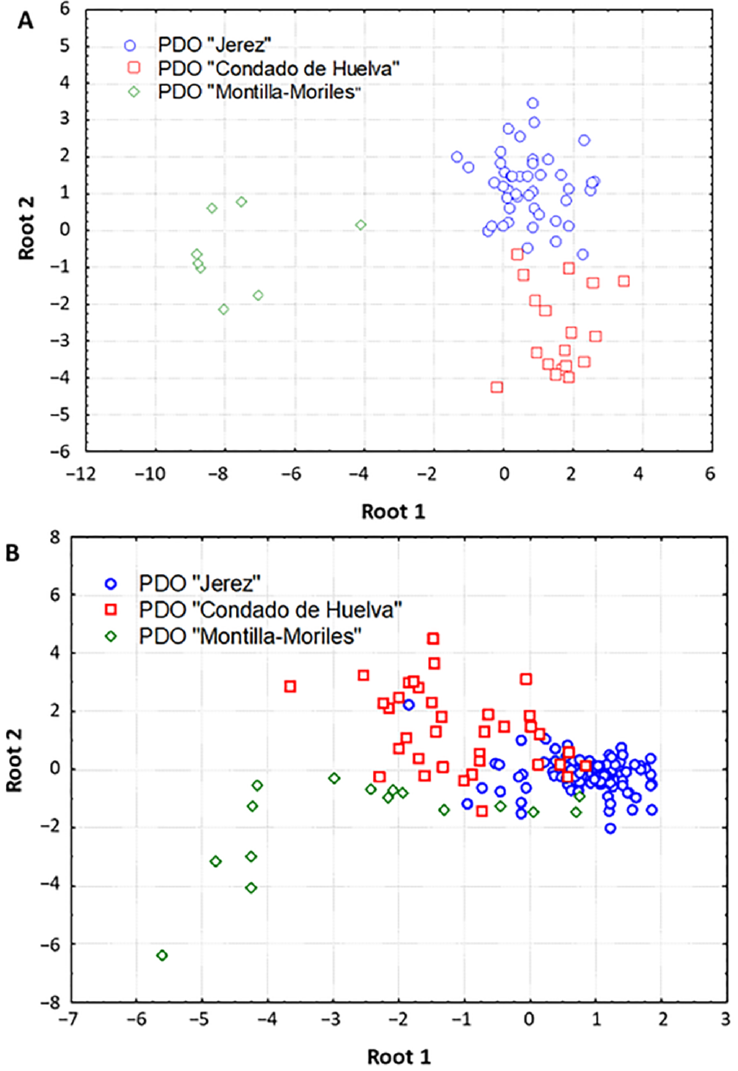
Figure 2. Linear discriminant analysis (LDA) scatter plots showing the distribution of samples in the space defined by the two first canonical variables using: ( A ) non-preprocessed UV-Vis spectral data, ( B ) SNV-preprocessed UV-Vis spectral data.